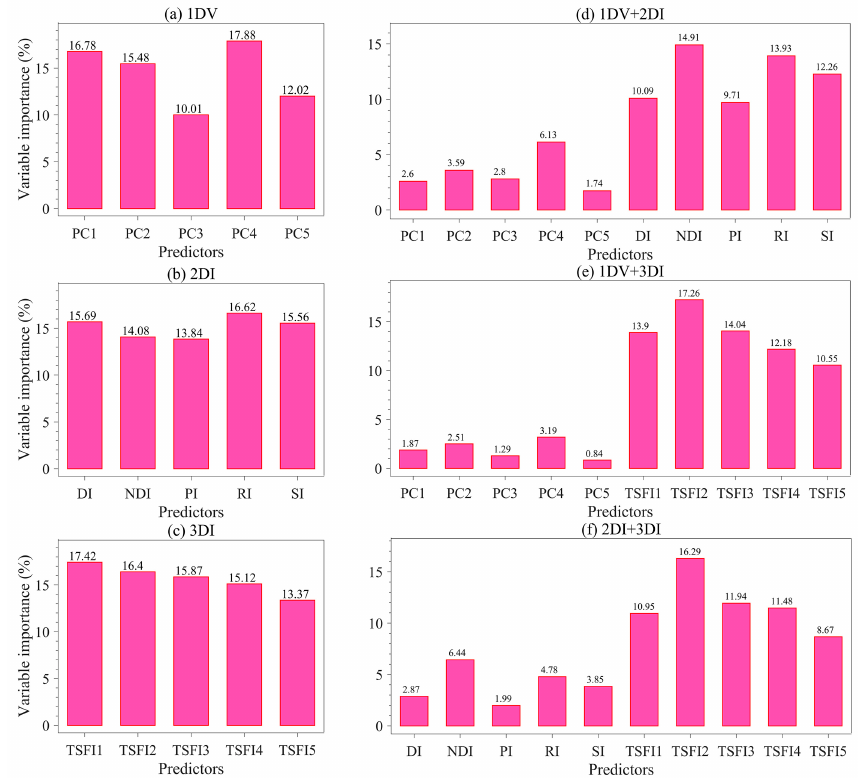
Figure 12. Relative importance (%) of the predictor variable from the RF model in different strategies to predict the SOM content. Each variable of importance was normalized to a 100% scale.